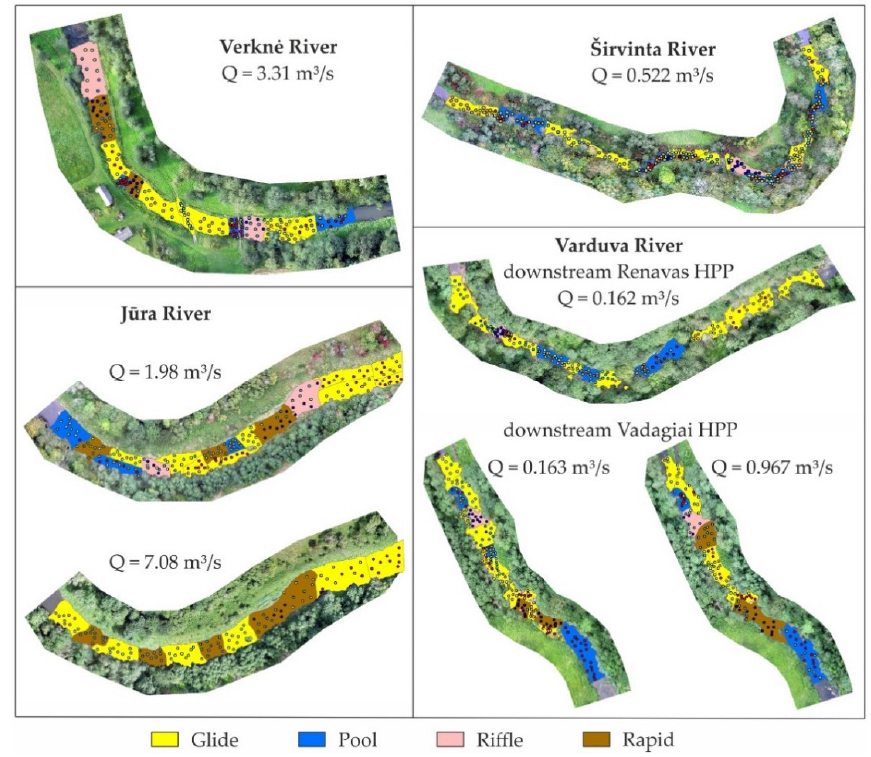
Figure 5. Distribution of the hydromorphological units and point measurements of hydraulic parameters across the selected case studies at certain discharges.